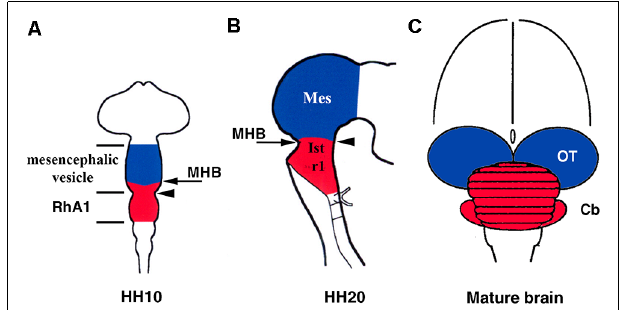
FIGURE 2 | Location of the isthmocerebellar (red) and mesencephalic (blue) anlages in the chick neural tube at stage HH10 (A) and HH20 (B) with respect to the midbrain/hindbrain boundary (MHB; arrows in A,B ). The arrowheads in (A) and (B) point to the mesencephalic/metencephalic (mes/met) constriction. Note that at stage HH20, the MH boundary and the mes/met constriction are coincident (B) , but not at stage HH10 (A) . The cerebellum (red) and mesencephalon (blue) are also shown in the mature brain (C) . Cb, cerebellum; Ist, isthmus (r0); Mes, mesencephalon; OT, optic tectum; RhA1, pro-rhombomere A1; r1, rhombomere 1. From Hidalgo-Sánchez et al.